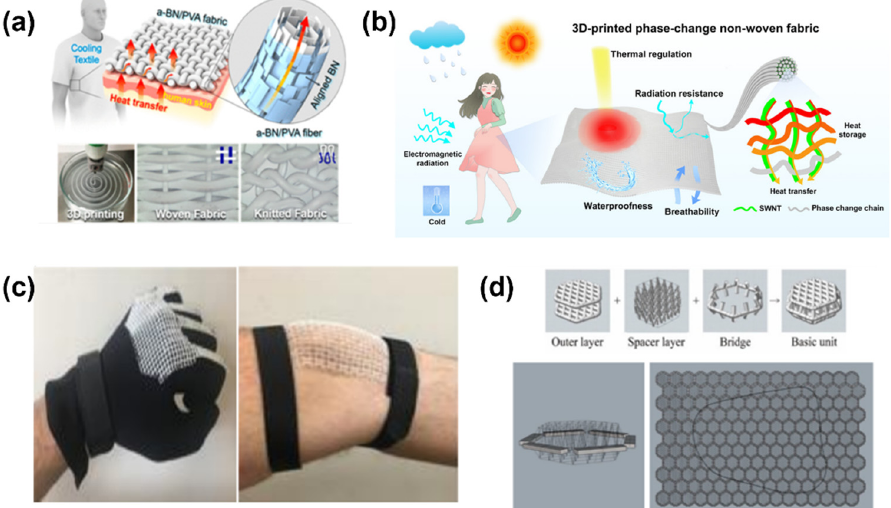
Figure 5. ( a ) The 3D printing of heat-adjusted textiles; ( b ) 3D printing of multifunctional, flexible phase-change nonwovens; ( c ) flexible grids which speed up finger recovery when clenching fists; ( d ) spaced hexagonal grids for fall-protective clothing [72–76].